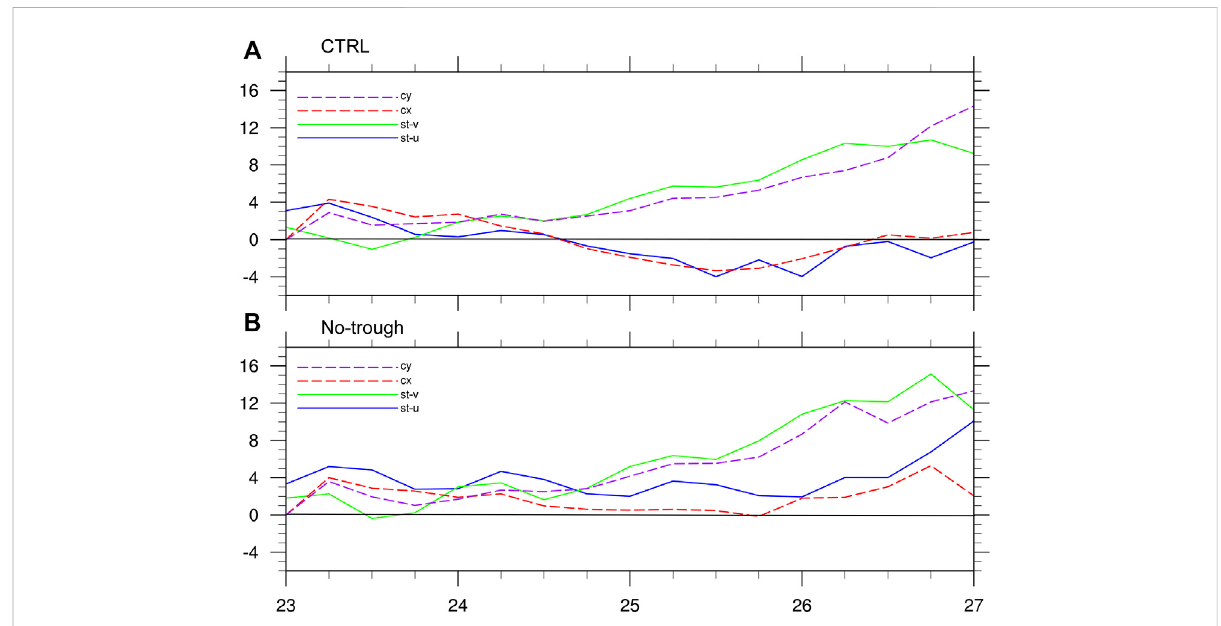
FIGURE 4 Timeseries ofthezonalandmeridional components (cx,cy; m s − 1 )ofTCtranslation speedestimated withdifferenceoftheTCcenter positions and steering fl ow (st-u, st-v; m s − 1 ) in the CTRL (A) and in No-trough experiments.